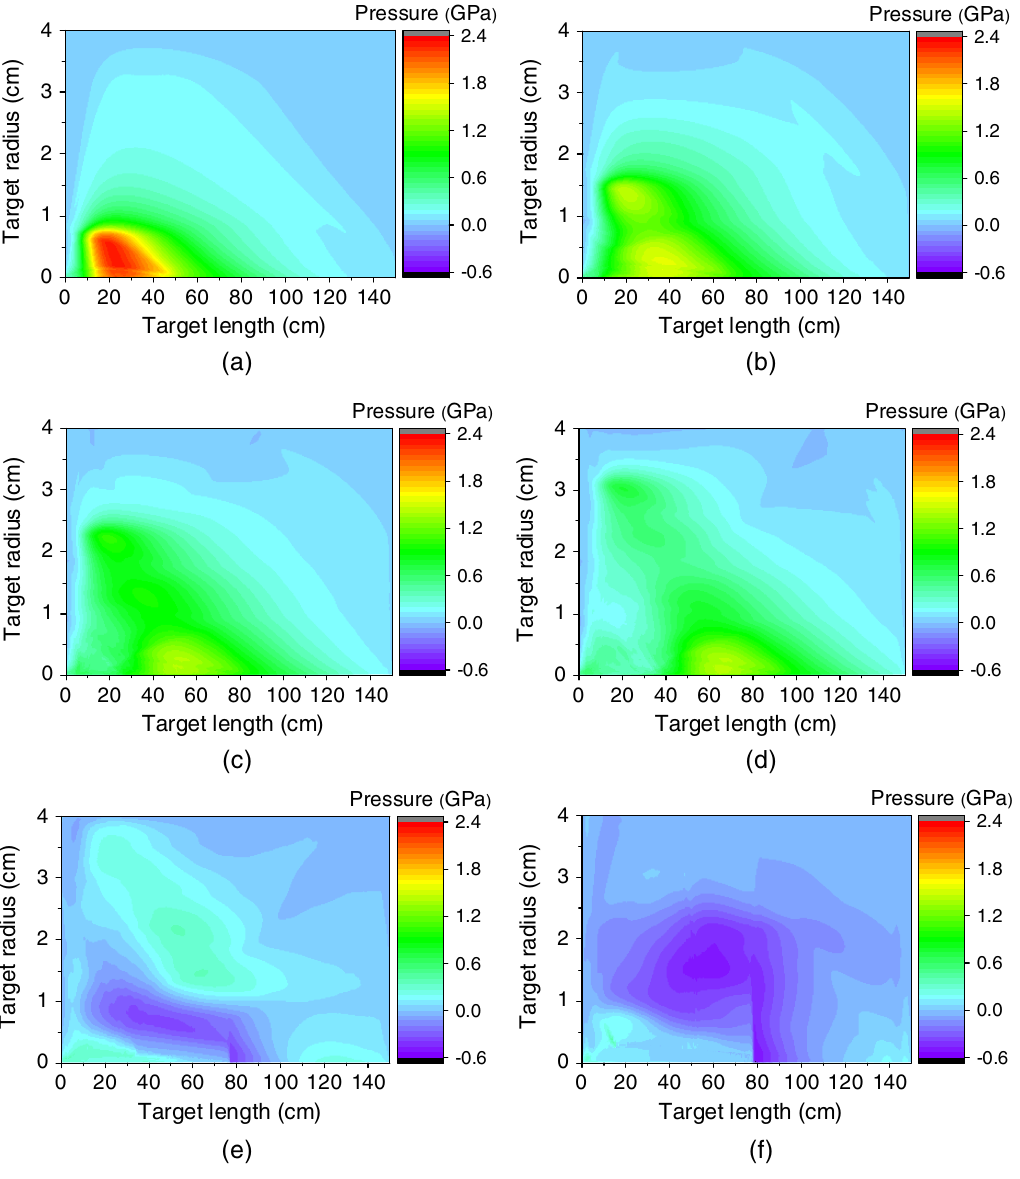
FIG. 8. Two-dimensional distributions of pressure in the r - z plane calculated by Autodyn (a) at t ¼ 1 . 8 μ s, after 36 bunches have been delivered, (b) at t ¼ 3 . 8 μ s, after 72 bunches, (c) at t ¼ 5 . 8 μ s, after 108 bunches, (d) at t ¼ 7 . 8 μ s, after 144 bunches, (e) at t ¼ 10 μ s, 2 . 2 μ s after the delivery of the beam, and (f) at t ¼ 20 μ s, 12 . 2 μ s after the delivery of the